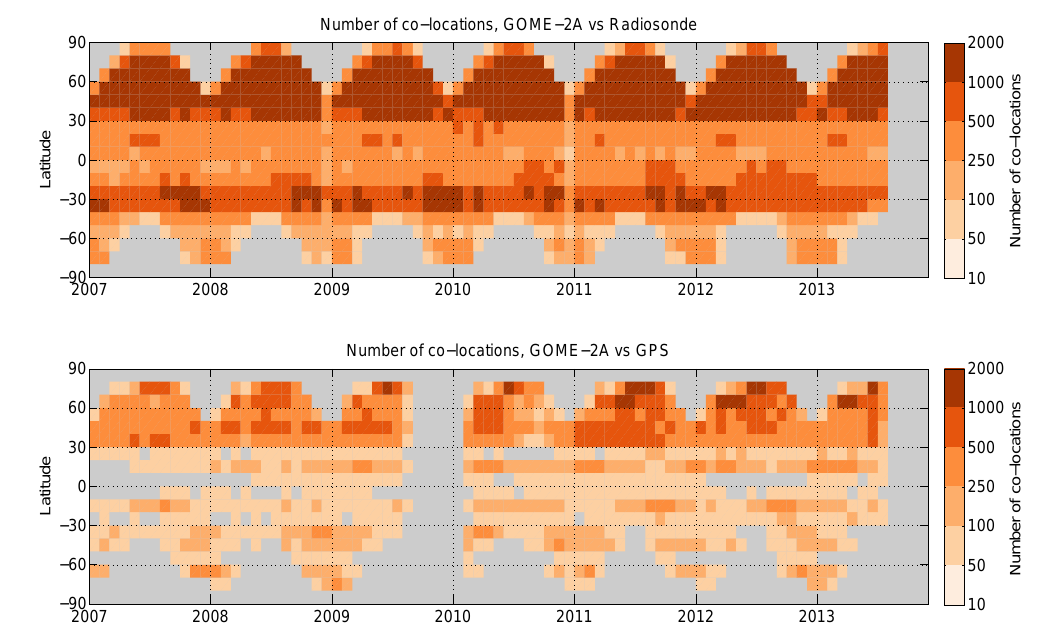
Figure 8. Number of co-locations per month and 10 ◦ latitude zone, for GOME-2A vs. radiosonde (top) and GPS (bottom).